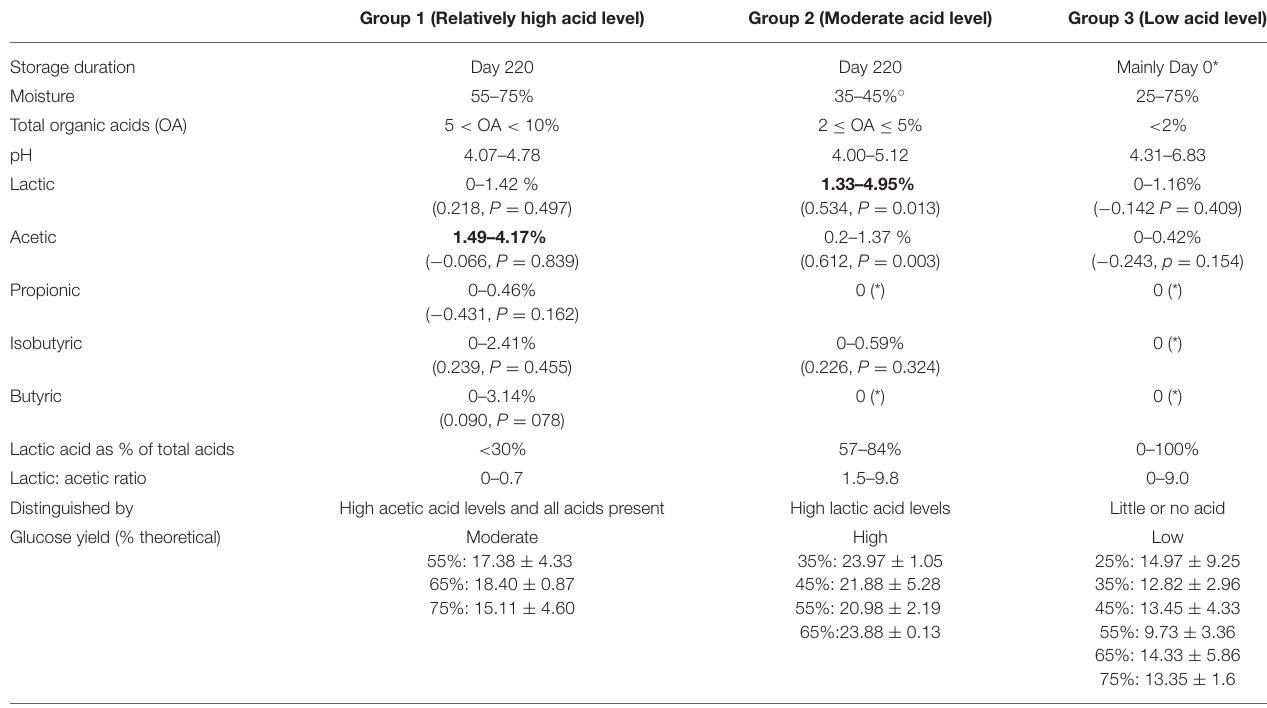
TABLE 3 | Differences in the three organic acid groupings and correlation of individual acids with